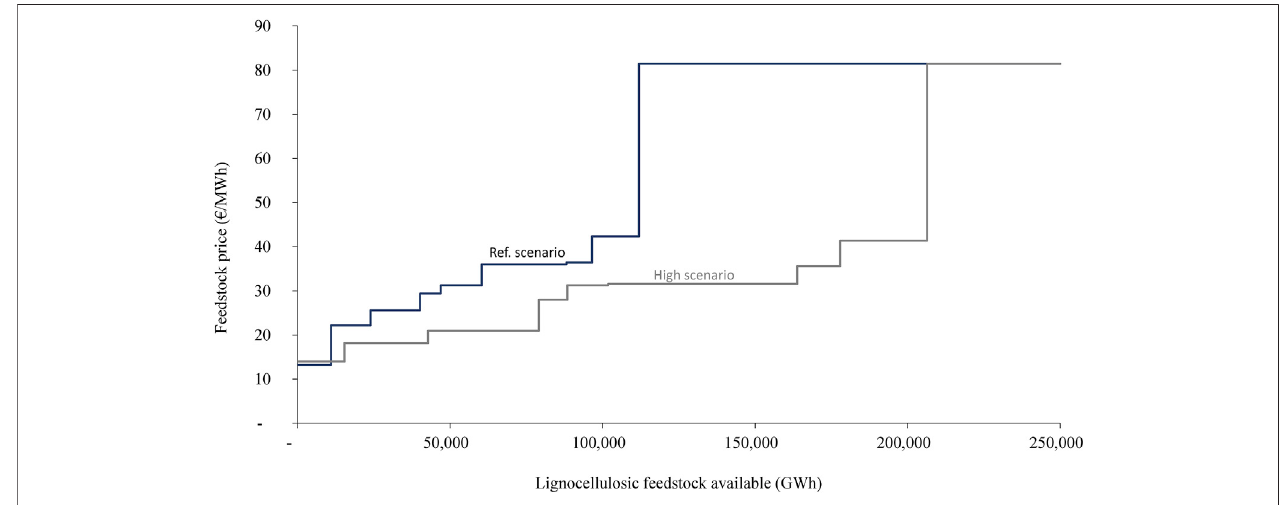
FIGURE 1 | Cost supply curves of the lignocellulosic feedstock considered available for Belgium for the reference and high potential scenarios.